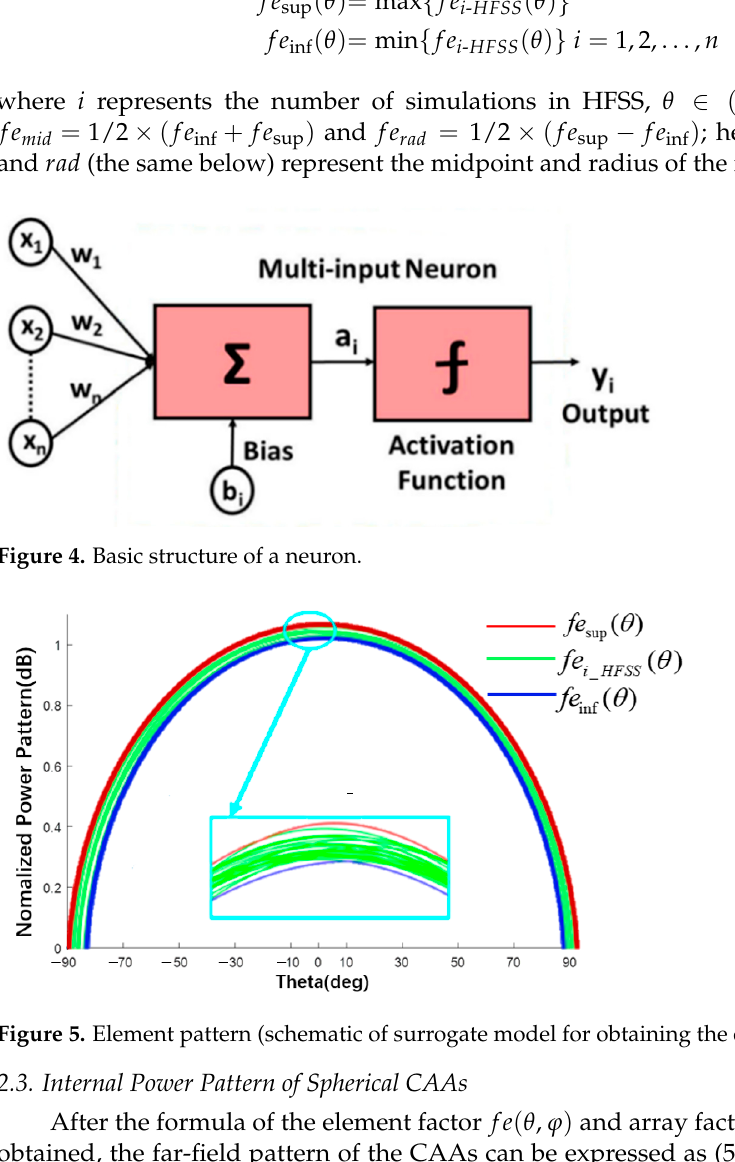
Figure 5. Element pattern (schematic of surrogate model for obtaining the element factor interval).